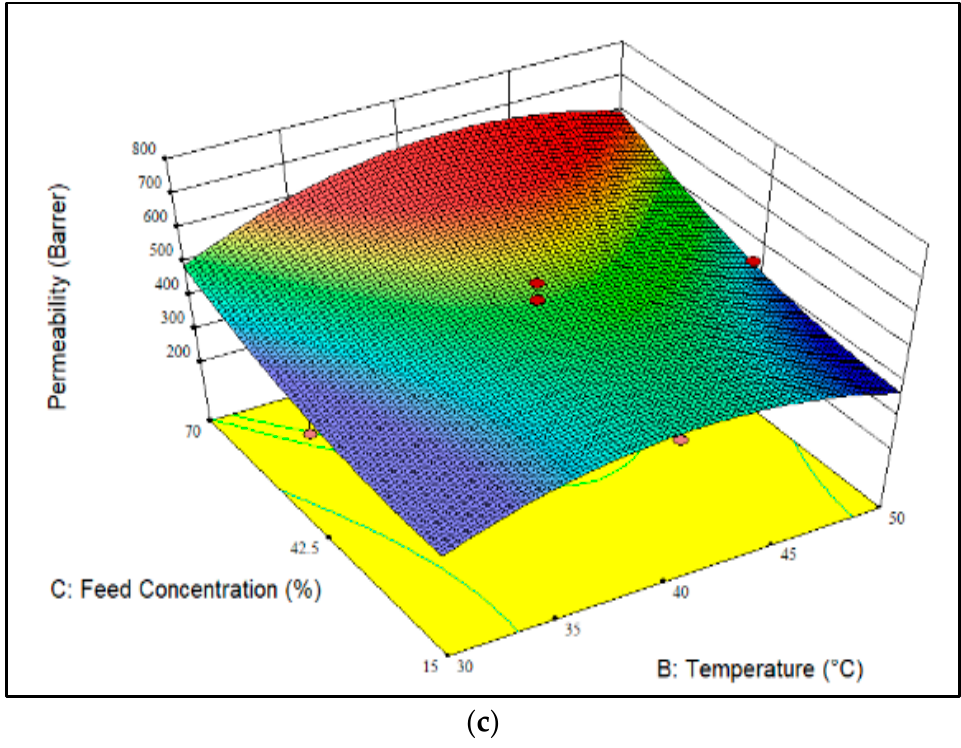
Figure 1. 3D surface of the CO 2 permeability as a function of feed pressure, CO 2 feed concentration and temperature at ( a ) CO 2 feed concentration of 42.5 mol%, ( b ) temperature of 40 °C and ( c ) feed pressure of 8 bar. (The darker colour (red) representing higher membrane performance whereas a lighter colour (blue) indicating lower membrane performance).